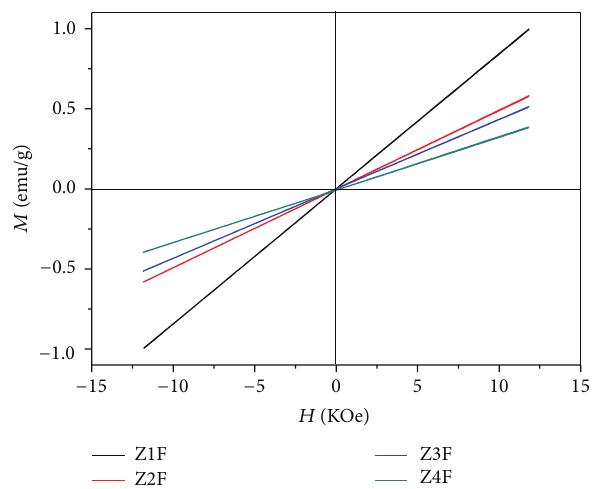
Figure 5: Paramagnetic contribution of the hysteresis loop after the calcination.